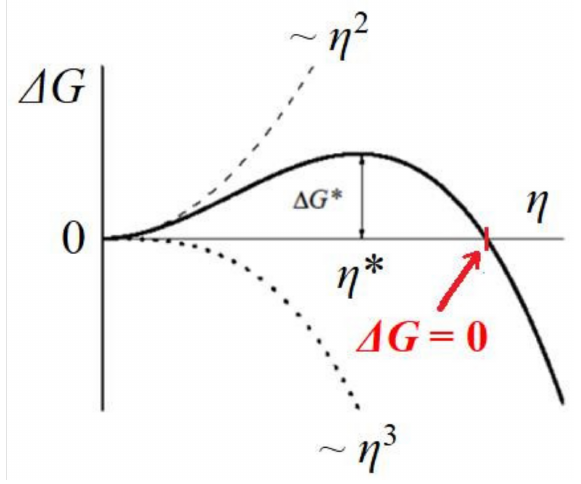
Figure 5. Change in Gibbs free energy ∆ G with the number η of building blocks at the edge of the crystal. The critical nucleus size η * arises at ∆ G *. The red arrow shows the point where ∆ G = 0. For crystallization in solutions, the supersaturation ∆ µ = k B Tln energy for crystal nucleation; k B is the Boltzmann constant; T is the absolute temperature;